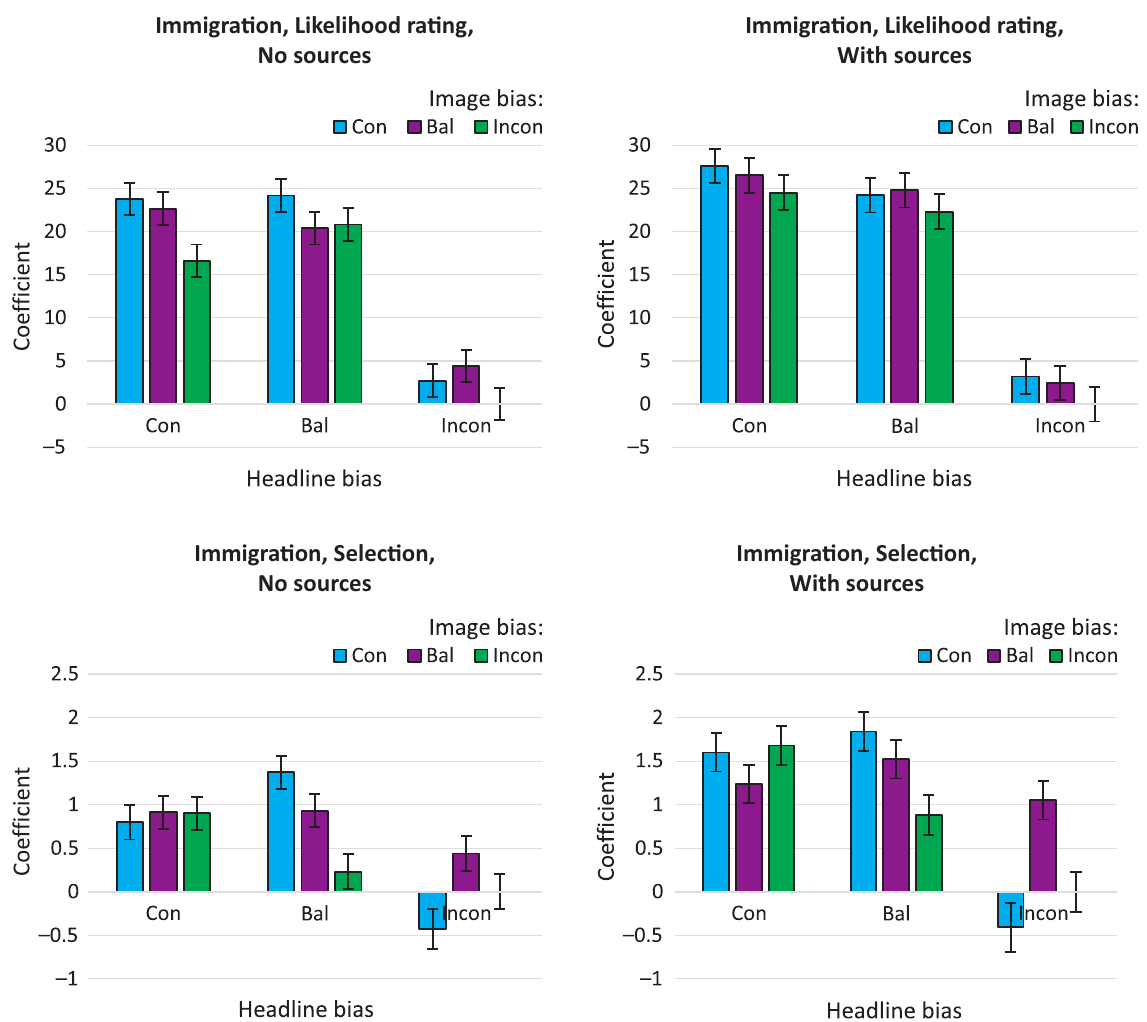
Figure 4. Coefficient plot comparing the selection of immigration news items with matching and non-matching headlines and images. Notes: Incon-Incon condition is used as the reference category. Regression coefficients and standard errors are plotted. Con = attitude congruent; Bal = balanced; Incon = attitude